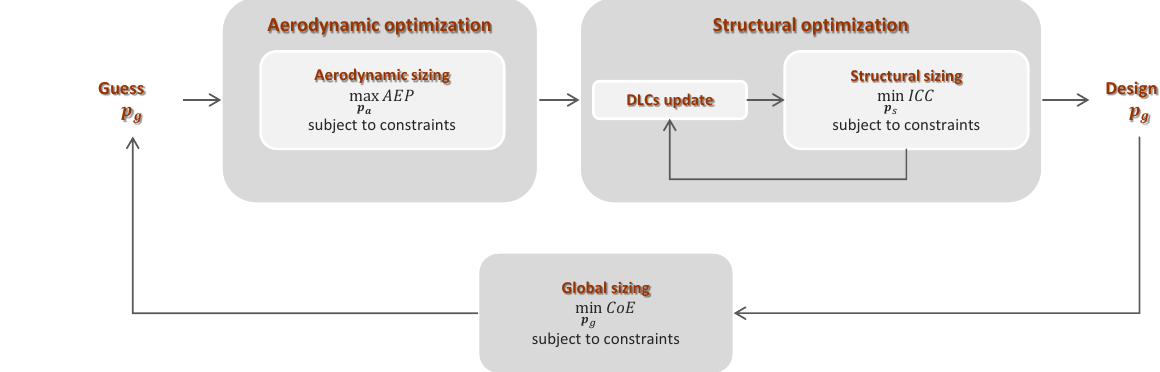
Figure 2. Architecture of the combined preliminary–detailed design